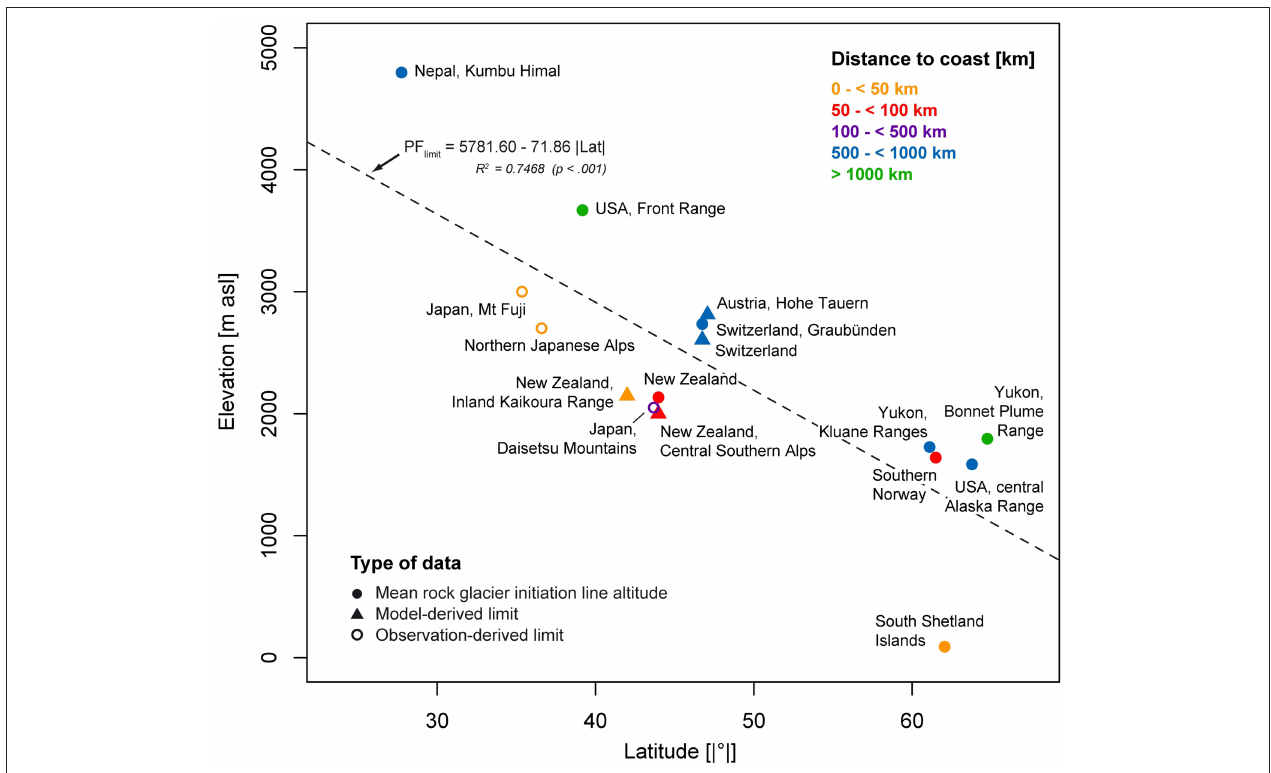
FIGURE 9 | Comparison of the Southern Alps’ lower permafrost distribution limits to data from selected other temperate climate regions according to distance to sea. Full circles ( • ) represent limits derived from the mean rock glacier initiation line altitude of active features; sources: Nepal, Kumbu Himal, Regmi (2008) ; USA, Front Range, Janke (2007); Switzerland, Graubünden, Haeberli (1975); Canada, Yukon, Page (2009); Southern Norway (active and inactive rock glaciers), Lilleøren and Etzelmüller (2011); USA, central Alaska Range, Wahrhaftig and Cox (1959); South Shetland Islands, Serrano and López-Martıìnez (2000). Full triangles ( N ) represent limits derived from distribution models; sources: Austria, Hohe Tauern (steep slopes, probable permafrost limit), Schrott et al. (2012); Switzerland (steep slopes, possible permafrost limit), Haeberli (1996). Empty circles ( ◦ ) represent limits derived from permafrost observations in the Japanese Alps, published in Matsuoka (2003). Dashed line represents the dataset’s average polewards decrease in permafrost limits of 72m per degree latitude.